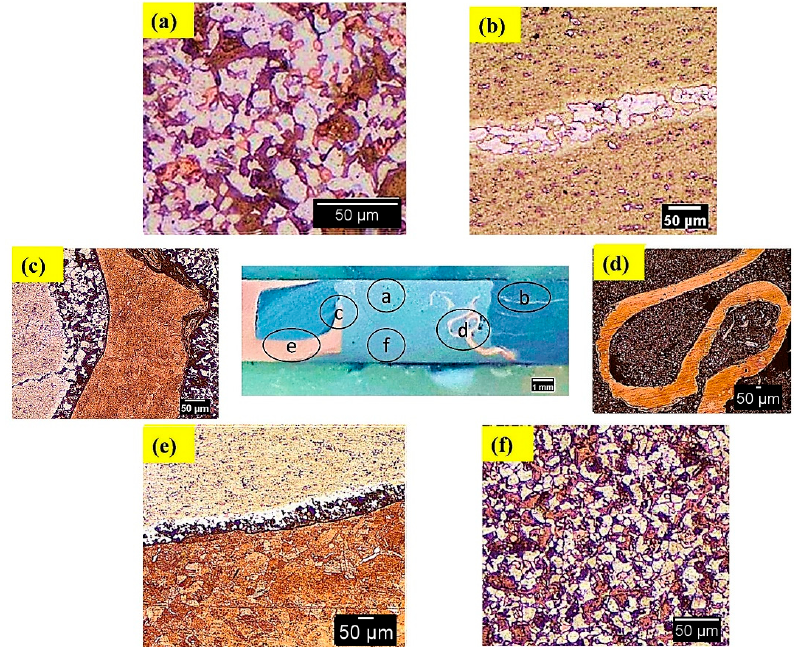
Figure 6. Microstructure in Al/Cu joint formed by BTFSW at ( a , b ) top, ( c , d ) middle, ( e , f ) bottom.